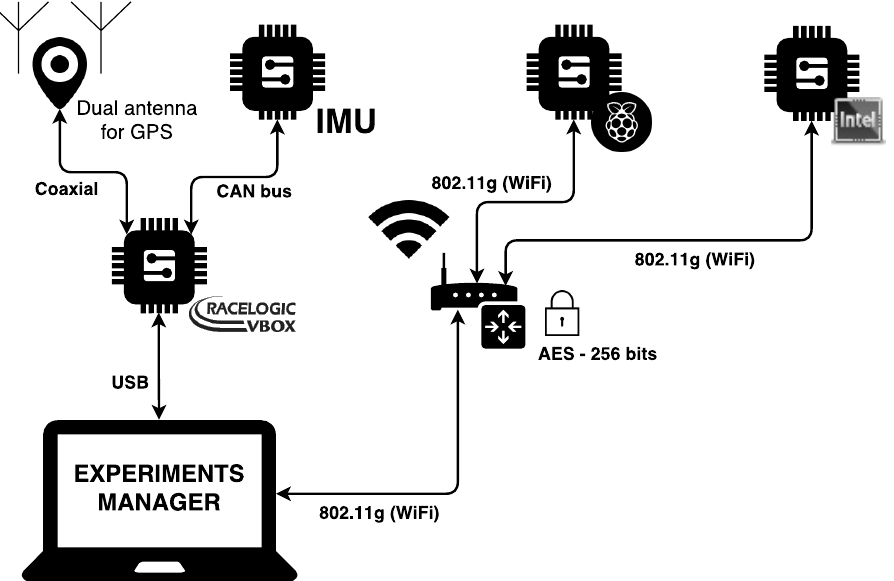
Figure 3. Testbed communications